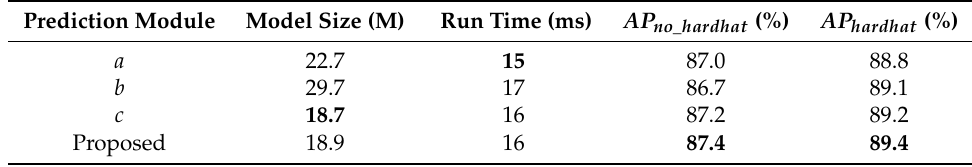
Table 2. Performance comparison for different prediction modules (bold indicates either best performance or minimum